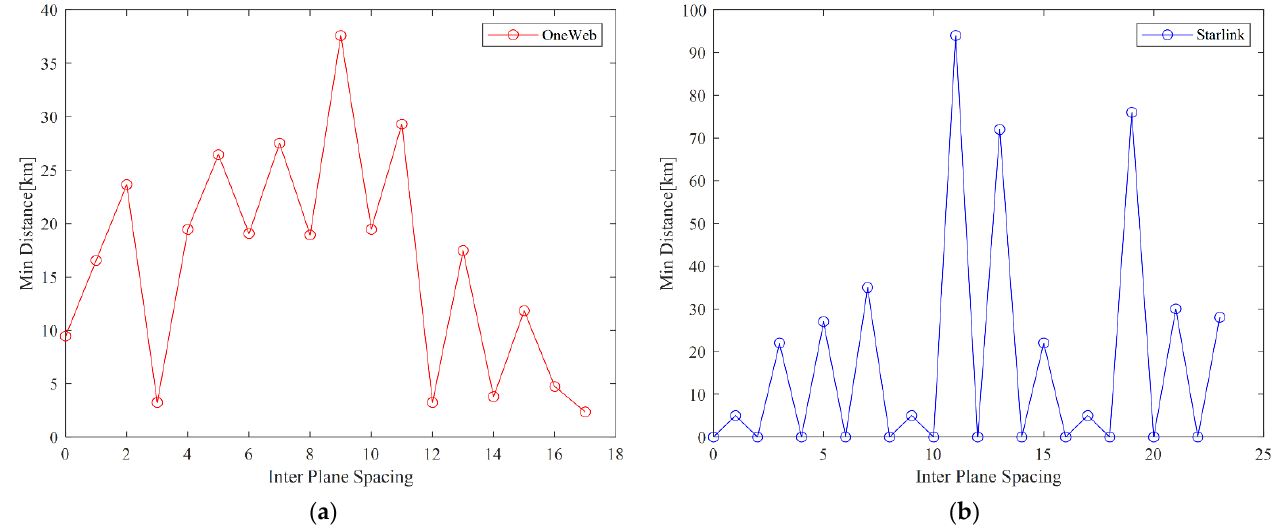
Figure 6. Solving for the optimal Phasing Factor. ( a ) The variation of the OneWeb constellation, where 0 ≤ F ≤ 17; ( b ) The variation of the Starlink constellation, where 0 ≤ F ≤ 23.